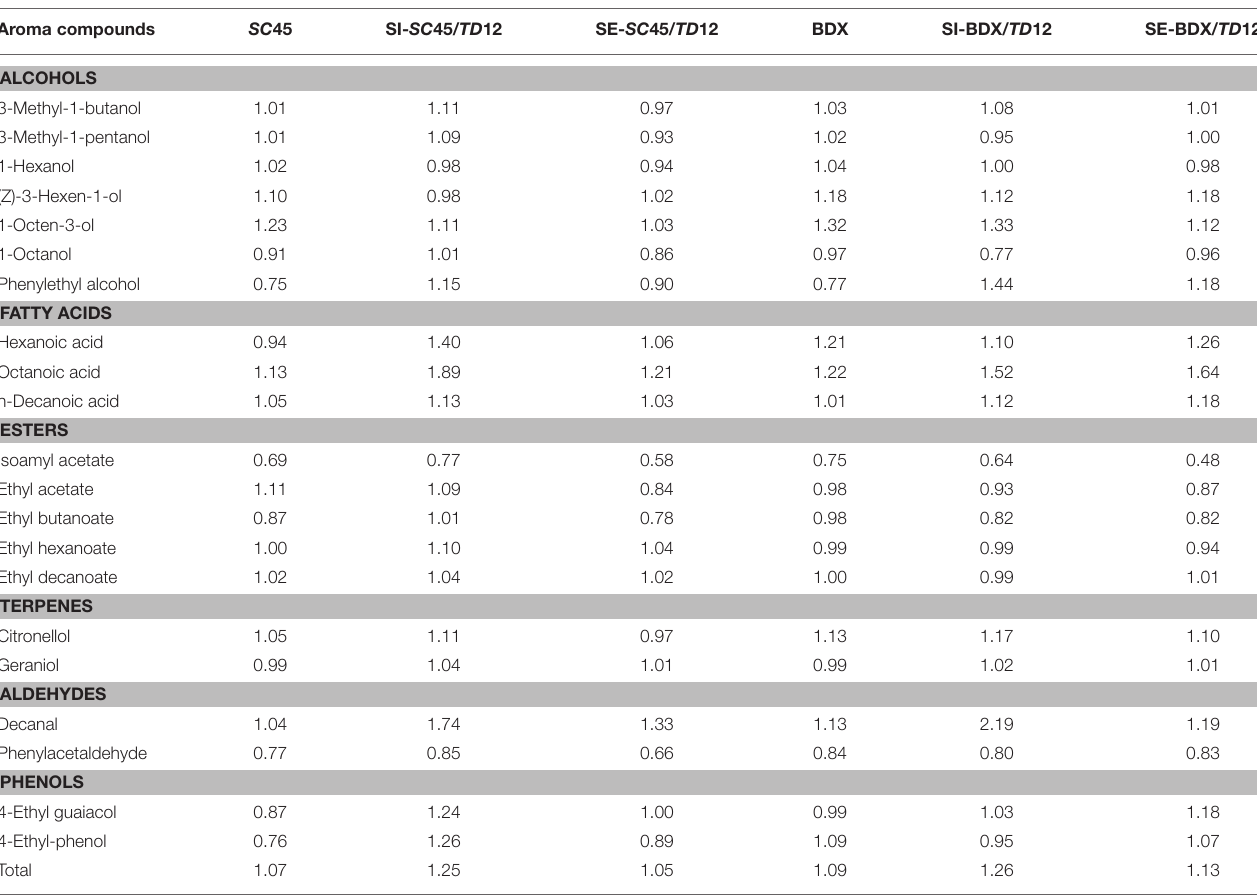
TABLE 4 | The ratio of aroma compounds (OVA > 0.1) after malolactic fermentation vs . after alcoholic